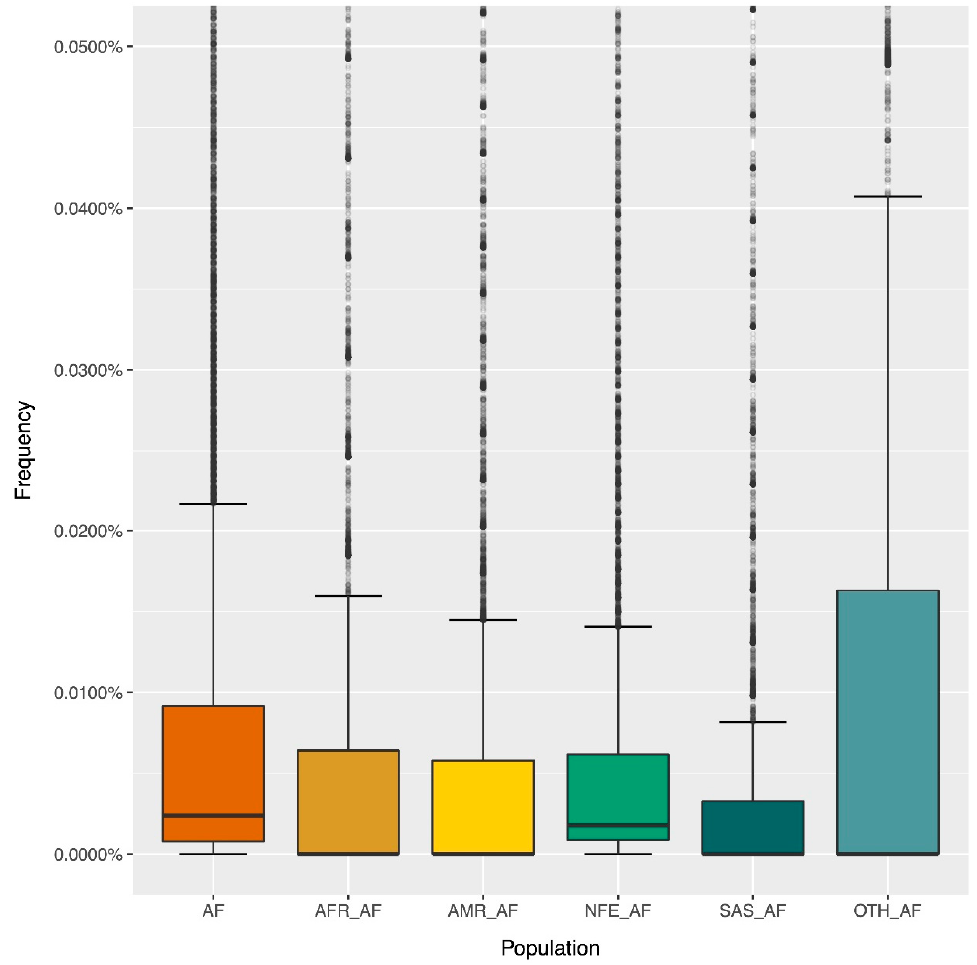
Figure 3. Boxplot of the MAFs (0% - 0.045%) of the PGx variants, identified within the DiscovEHR cohort, within various gnomAD populations. Abbreviations: MAF, minor allele frequency; PGx, pharmacogenomics; AF, combined gnomAD population; AFR_AF, African/African American; AMR_AF, Latino; NFE_AF, Non-Finnish European; SAS_AF, South Asian; OTH_AF, Other.